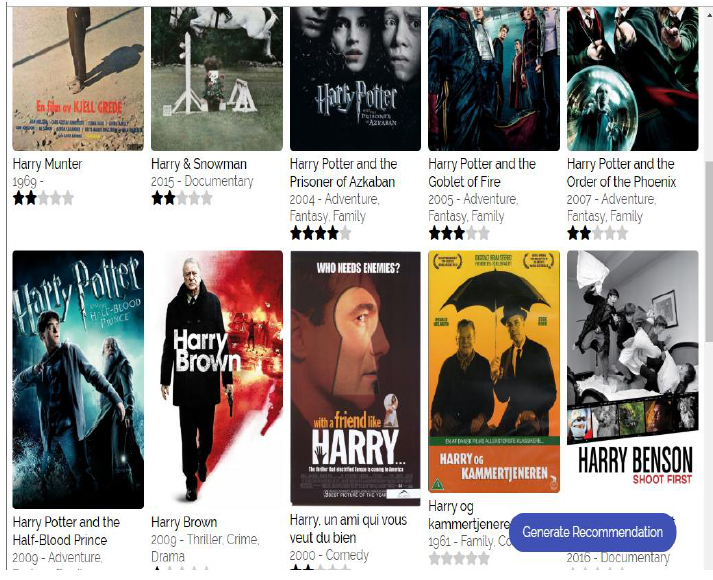
Figure 6. Rating